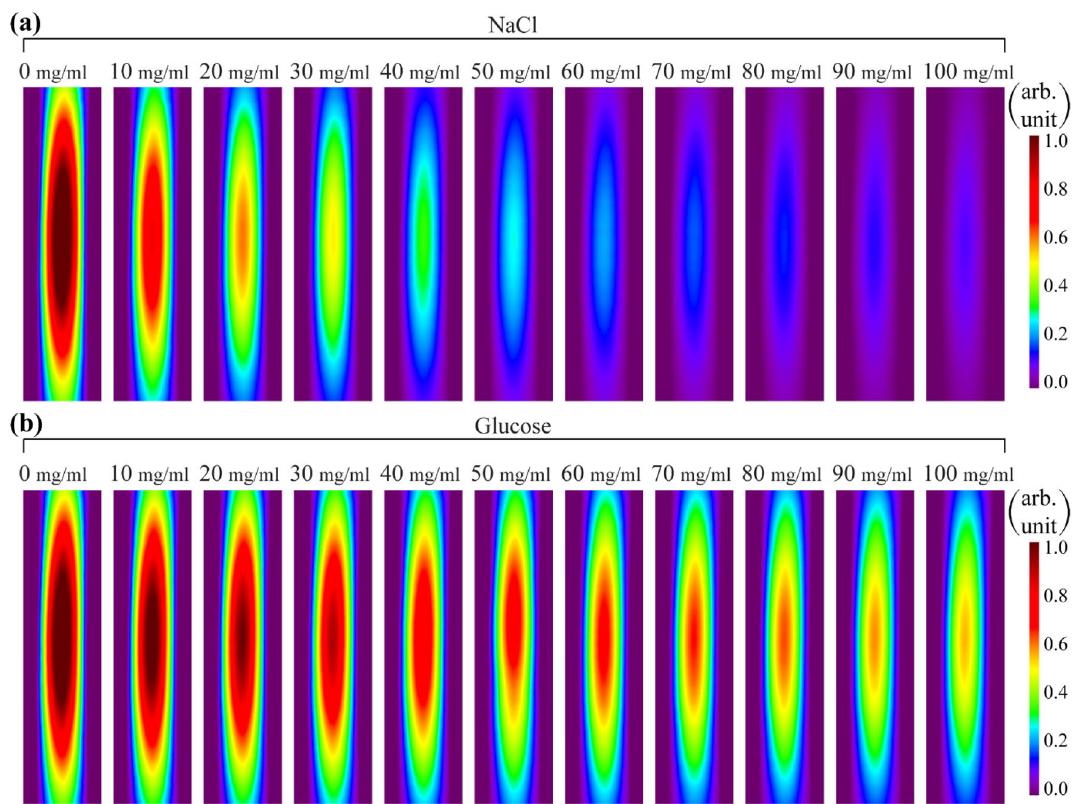
Figure 6. H-MWNF distribution images for ( a ) NaCl and ( b ) glucose aqueous solutions with 0–100 mg/ml concentration at 12 GHz visualized by TEOIM. Size of each image is 20 mm × 5